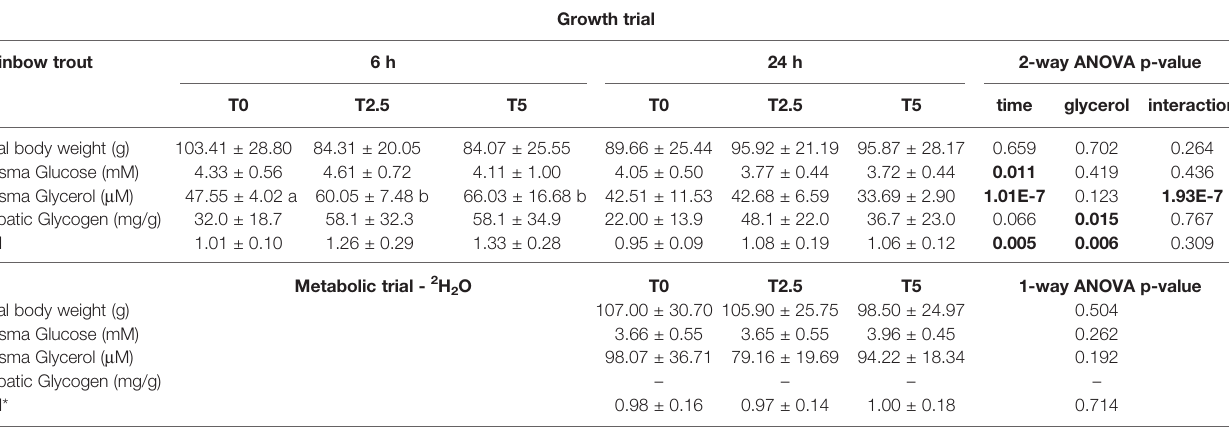
TABLE 3 | Final weight, blood and liver parameters for rainbow trout ( Oncorhynchus mykiss ) fed with different levels of glycerol (0, 2.5, and 5%) for 8 weeks sampled at the end of the growth trial at 6 h and 24 h after last meal and the metabolic trial (6-day residence in 2 H-enriched water) 24 h after last meal. Growth